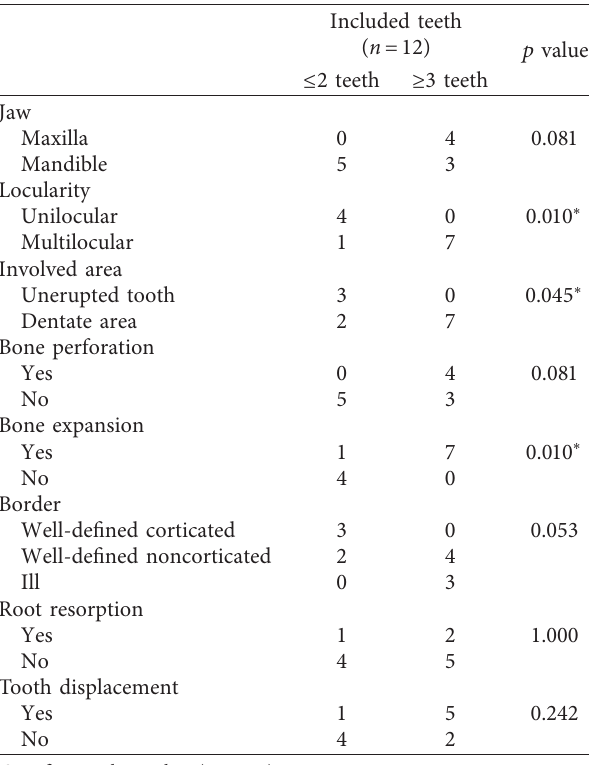
Table 4: Relationships between the number of included teeth of odontogenic myxoma and jaw, locularity, involved area, bone perforation, bone expansion, border, root resorption, and tooth